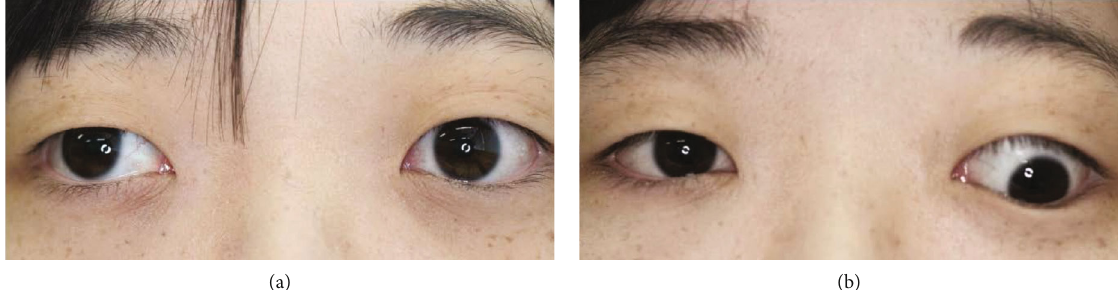
Figure 4: Clinical photographs of the patient. Eye positions are shown for (a) left-eye fi xed and (b) right-eye fi xed conditions. The original abnormality of the eye position was con fi rmed as shown in